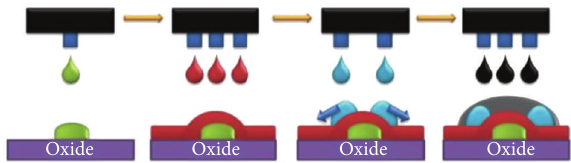
Figure 14: Step by step process for fabrication of device using inkjet printing [98].